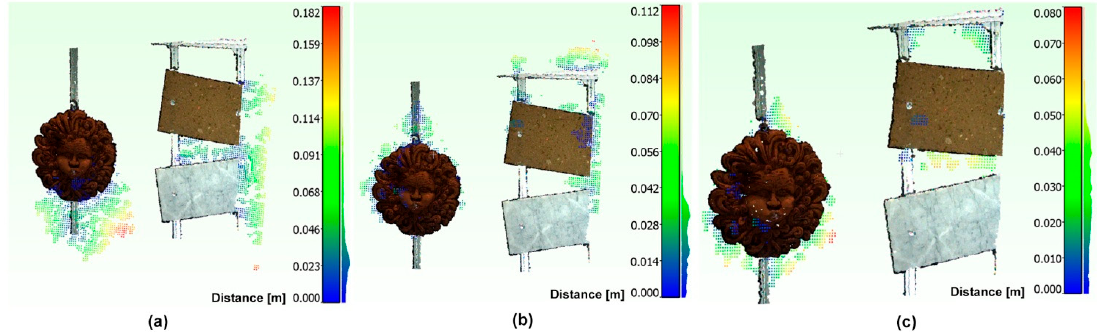
Figure 18. Alignment of opto-acoustic 3D point clouds of the panel with objects, obtained through the